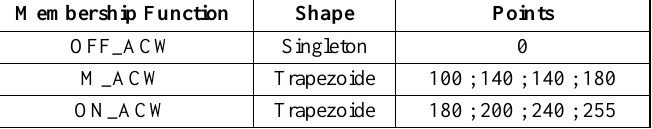
Table 8: Functions member of the Polar motion engine.